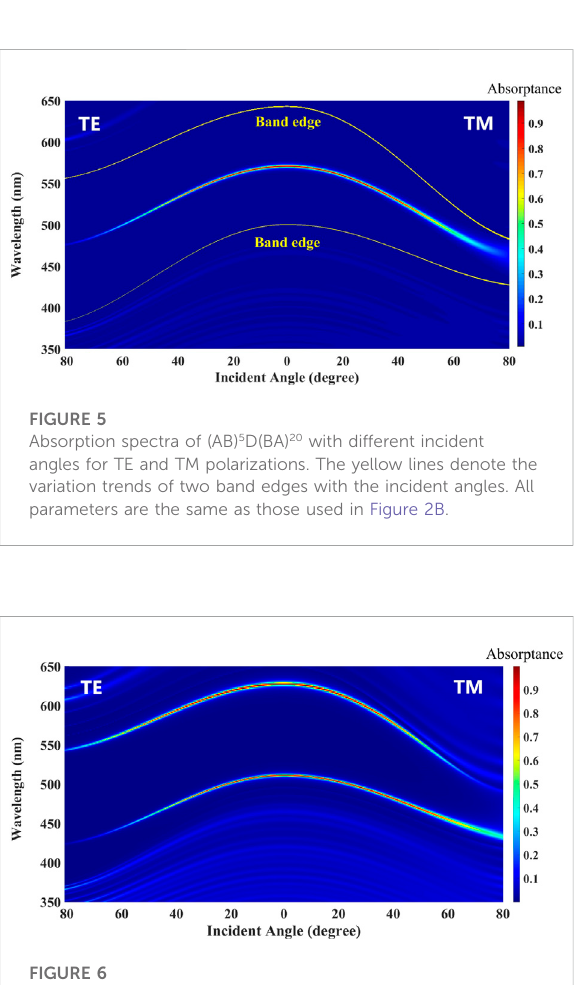
FIGURE 6 Absorption spectra of (AB) 5 D(BA) 20 with different incident angles for TE and TM polarizations. All parameters are the same as those used in Figure